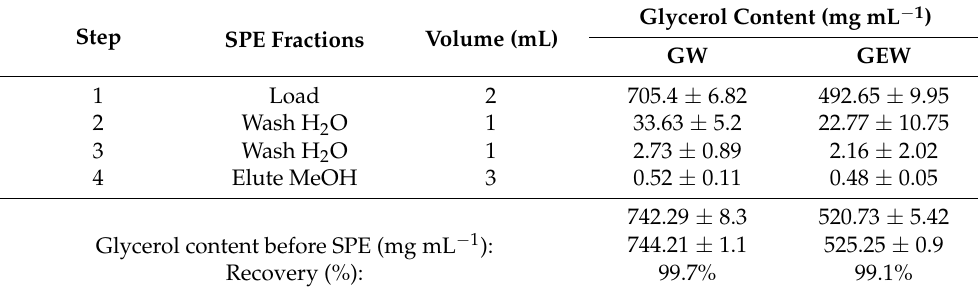
Table 1. Glycerol content of SPE fractions from QGP extracts (GW and